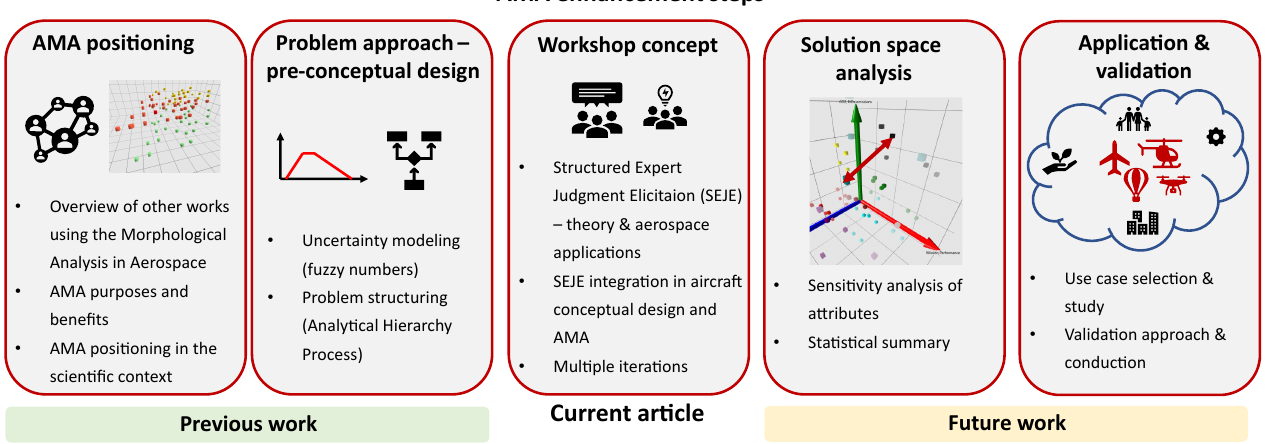
Figure 1. Main AMA enhancement